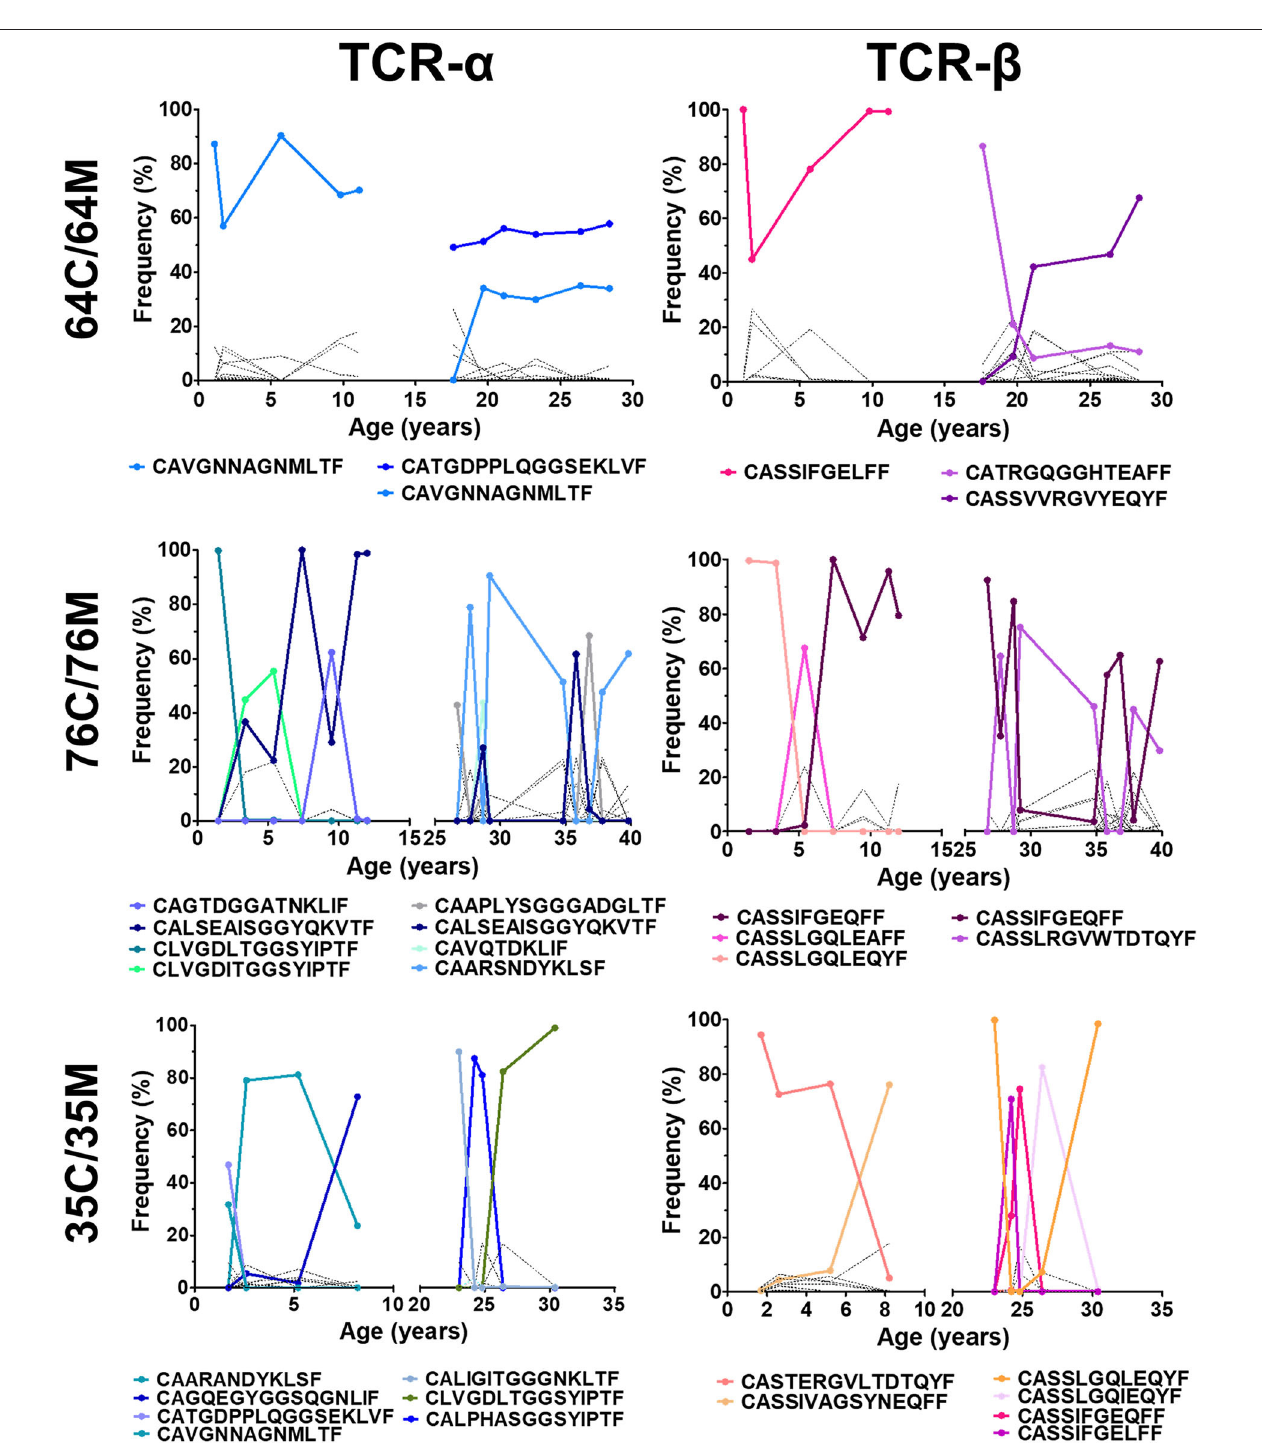
FIGURE 4 | Clonotypic TCR superdominance is maintained in children and adults over time. The frequency of TCR- α (left) and TCR- β (right) is shown for three mother-child pairs monitored between 2005 and 2017. Superdominant clonotypes for each subject are shown in solid coloured lines. All other clonotypes are represented by solid black lines. A clonotype is considered superdominant if its frequency exceeds > 30% at any point.